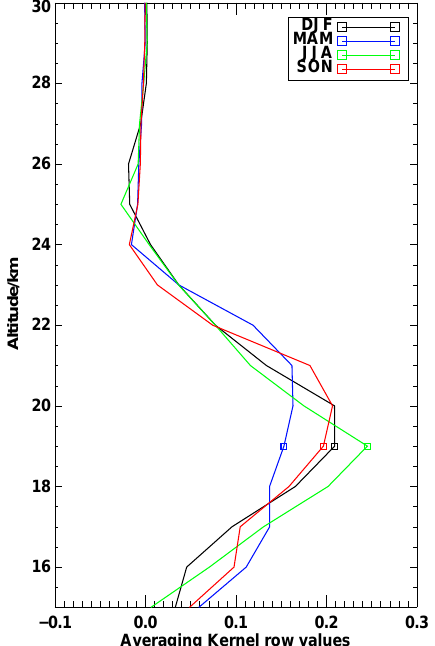
Figure 1. H 2 O averaging kernels for December, January, February (DJF, black line), March, April, May (MAM, blue line), July, July, August (JJA, green line) and September, October, November (red line) at 19km nominal altitude, 0–10 ◦ S. It should be noted that the kernels refer to log(vmr), not vmr.